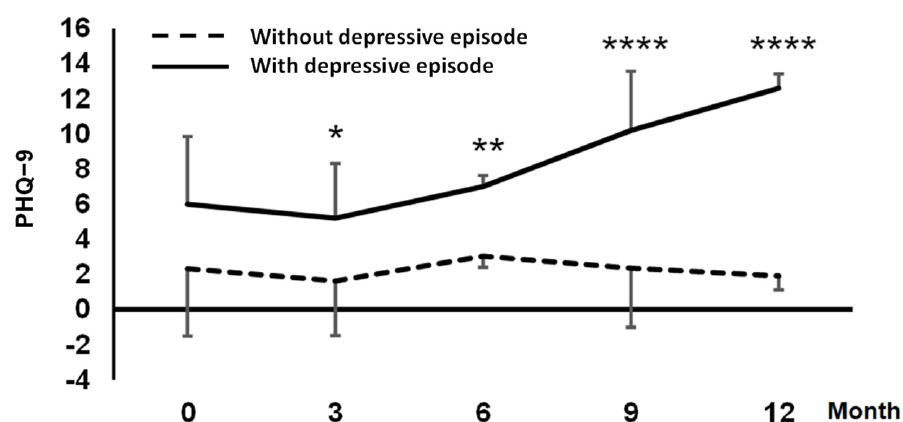
Figure 1. Average and standard deviation of time-series changes in PHQ-9. The solid line indicates the depressive episode group ( n = 5), and the dotted line indicates the nondepressive episode group ( n = 25) with PHQ-9 reaching ≥ 10 at the 12-month stay. Data between the two groups at each time point were compared using Mann–Whitney tests. * p < 0.05, ** p < 0.01, **** p < 0.0001.